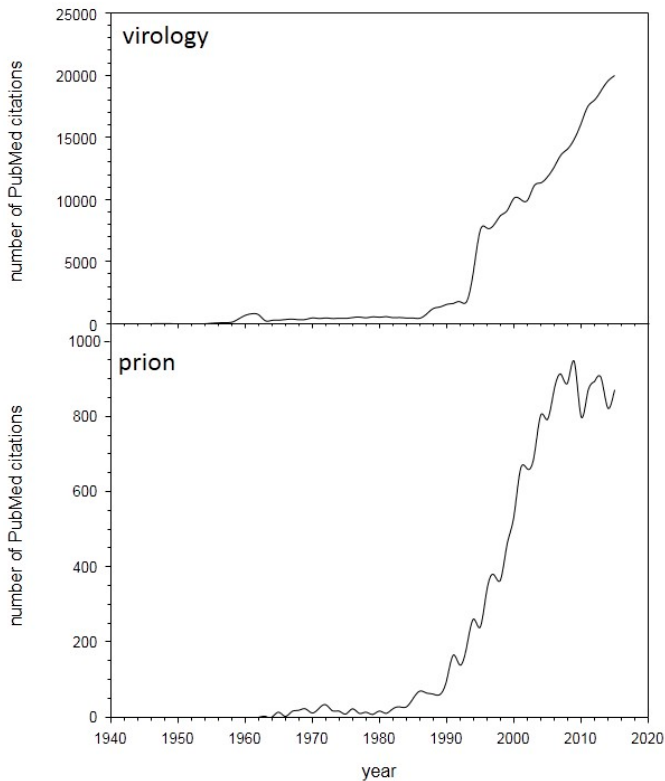
Figure 1. PubMed citations by year using virology ( top panel) and prion ( bottom panel).